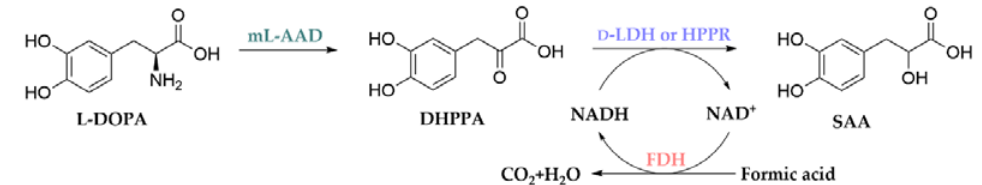
Figure 1. Schematic of the synthesis of salvianic acid A (SAA) from L -DOPA. DHPPA: 3,4-dihydroxyphenylalanine; m L -AAD: membrane-bound L -amino acid deaminases; D -LDH: D -lactate dehydrogenase; HPPR: hydroxyphenylpyruvate reductase; FDH: formate dehydrogenase.